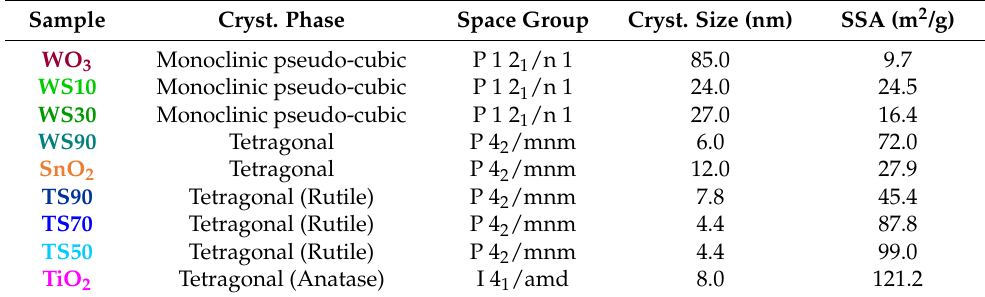
Table 1. Crystalline phases, space groups, mean crystallite sizes, and specific surface areas of the pure and mixed